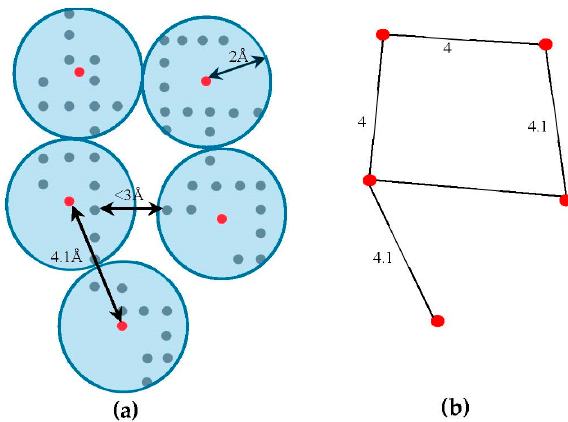
Figure 3. An example of building SKEL G for the skeleton. ( a ) The clusters from REDUCED model are built and centroids (shown in red) are calculated. Each centroid is a node in SKEL G graph; ( b ) Two centroids are connected if the distance between a voxel from the first centroid’s cluster is within 3 Å of any voxel from the second centroid’s cluster. The weights of the edges are the Euclidean distances between the